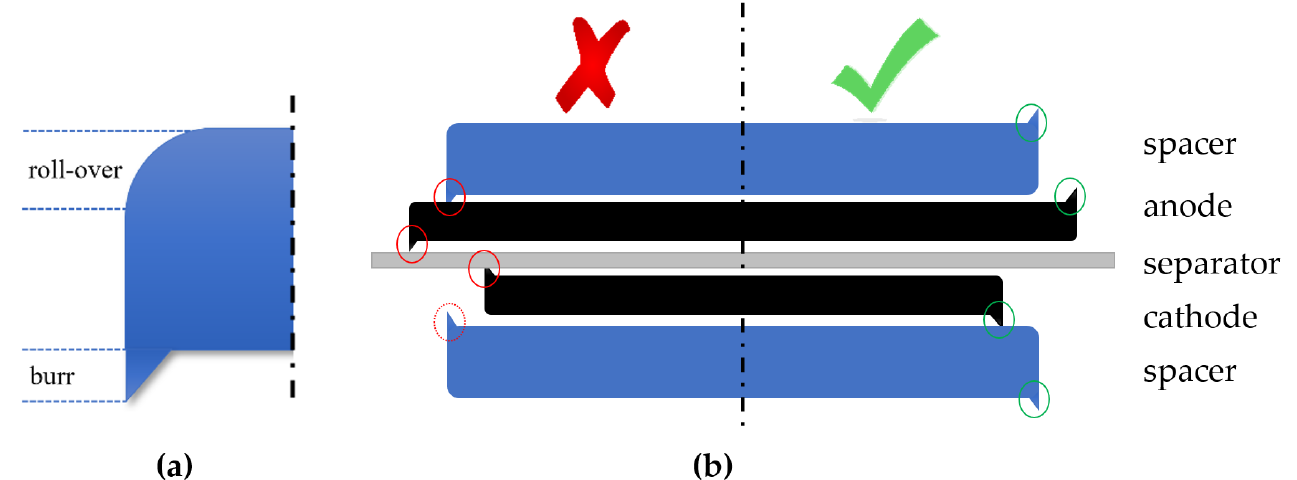
Figure 4. ( a ) Simplified geometrical shape of a punched disk; ( b ) alignment of punched coin cell materials (left: not suggested; right: suggested).